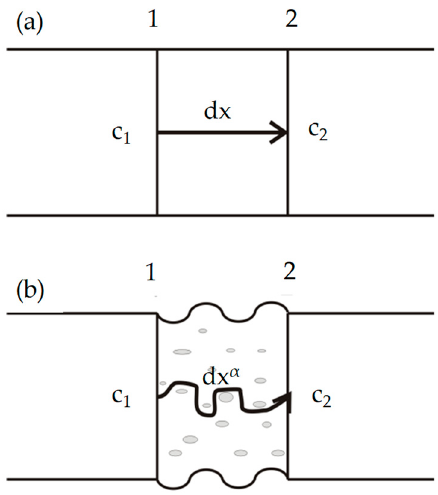
Figure 8. Schematic diagrams of Fickian diffusion of drug from ( a ) nonporous fibers and ( b ) porous fibers.